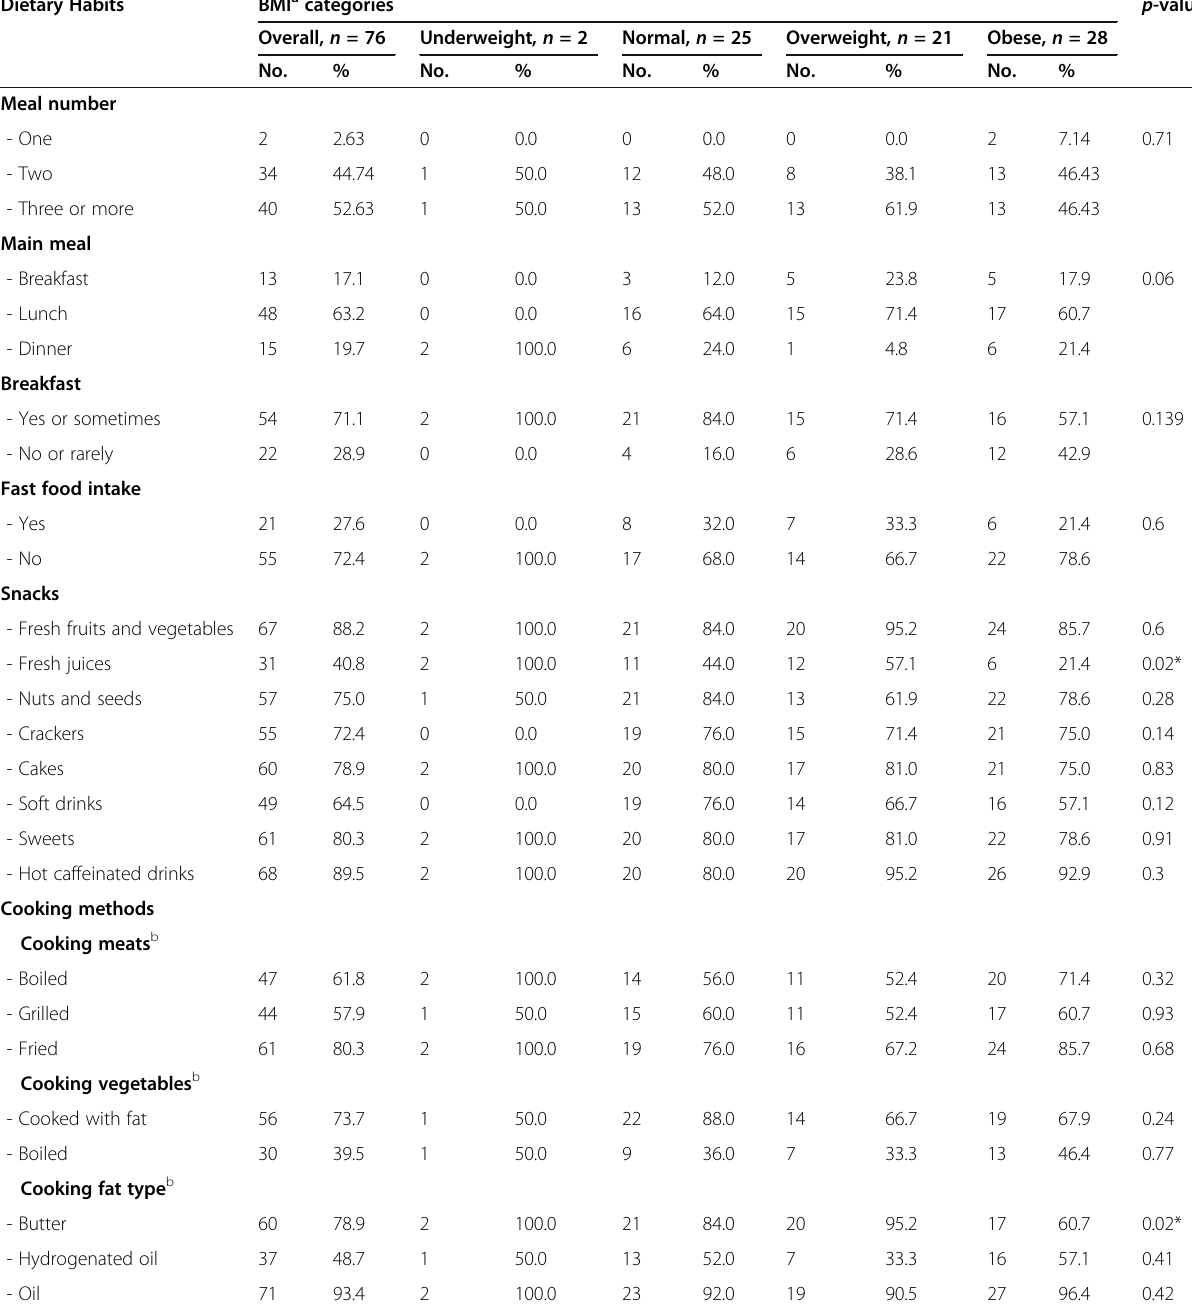
Table 2 Distribution of the studied multiple sclerosis patients at Kasr Al-Ainy Hospital by dietary habits and BMI Dietary Habits BMI a